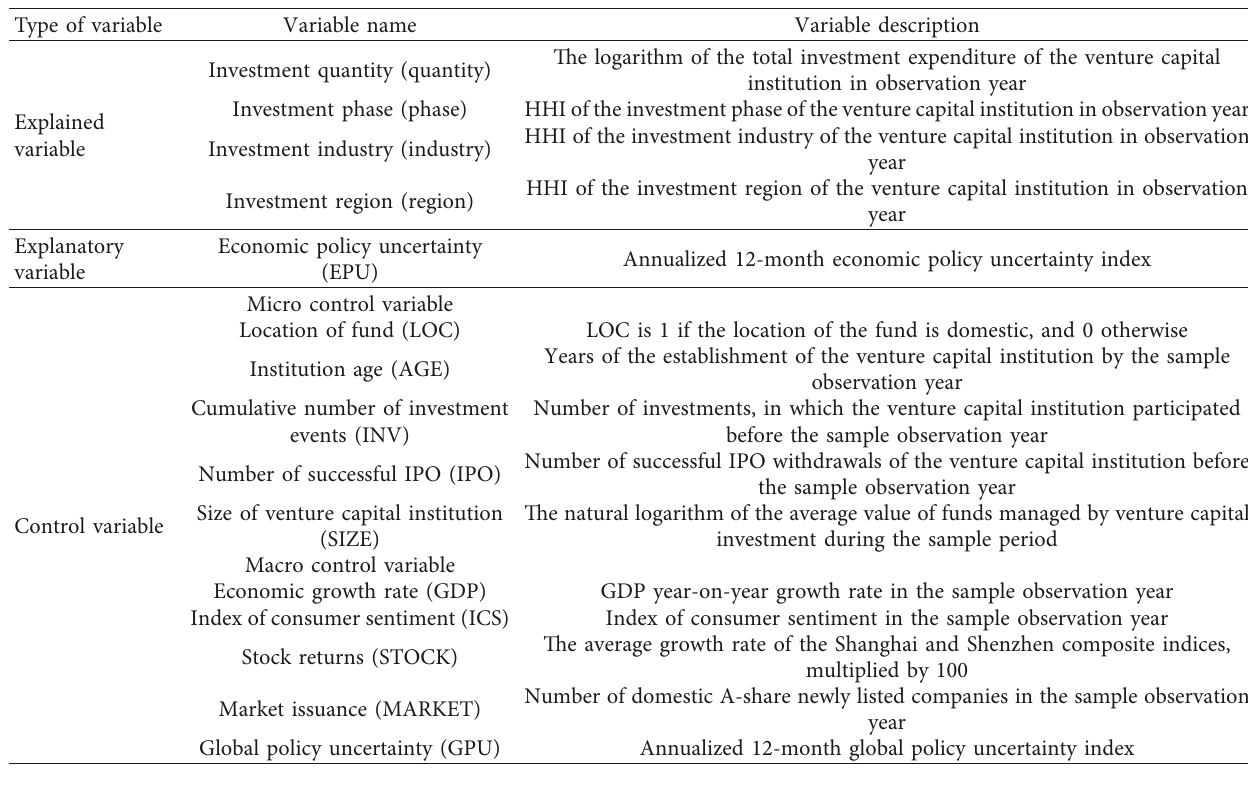
Table 1: Variable names and